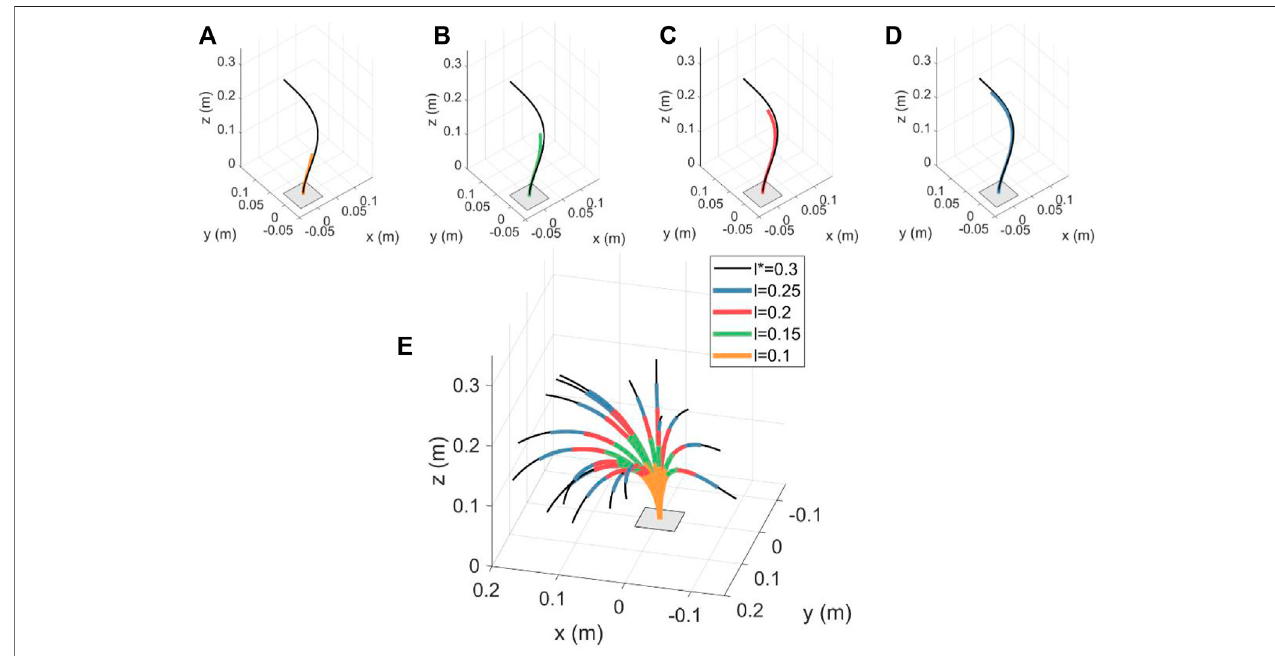
FIGURE 8 | FTL deployment results for varying segment lengths and con fi gurations. A Sequence-wise FTL deployment is shown in (A – D) . For α * = π rad and l * = 0.3 m, the desired path isshown inblack. The correspondingbackbone shape obtained forintermediate lengths with n = 10isshown in alternate colors for (A) l =0.1 m (B) l = 0.15 m (C) l = 0.2 m, and (D) l = 0.25 m. (E) FTL deployment results for 20 random values of α * and tensions. The corresponding spatial paths for n = 50 and the intermediate FTL deployment stages have been shown for different values of inserted length, i.e. l ∈ {0.1, 0.15, 0.2, 0.25